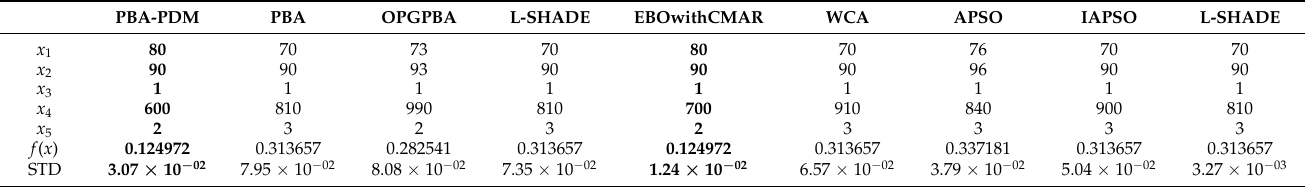
Table 17. The comparison of PBA-PDM with other optimizers in Multiple Disk Clutch Brake Design.